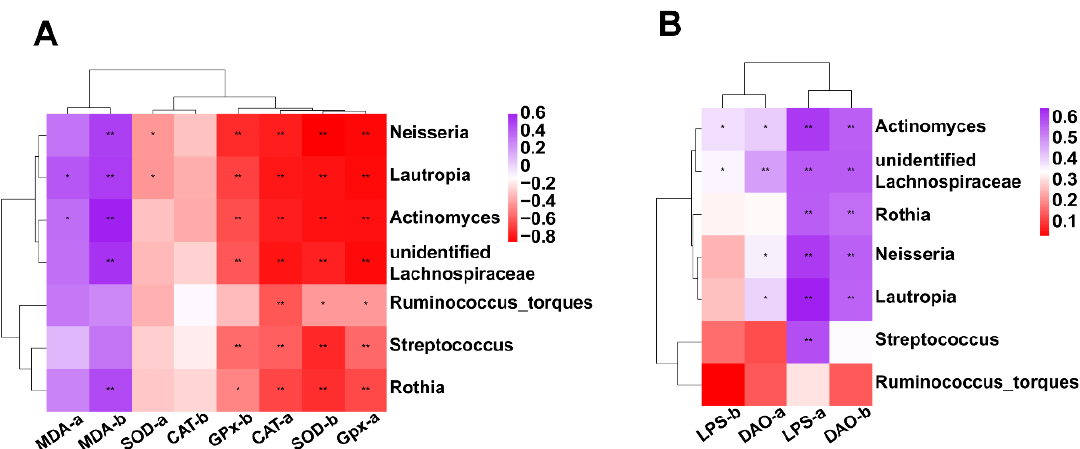
Figure 10. Correlation coefficient and significant analysis between gut microbiota (at genus level) and the parameters of antioxidant capacity or intestinal permeability of the heat-stressed broilers ( A ) Correlation between intestinal microbiota (at genus level) and antioxidant activity. “a” represents the parameters on day 28, and “b” represents the parameters on day 42. ( B ) Correlation between intestinal microbiota (at genus level) and permeability. “a” represents the parameters of 28-day-old broilers, and “b” represents the parameters of 28-day-old broilers. The purple to red color represents an axis from positive correlation to negative correlation. “*” indicates a significant difference between groups where p < 0.05. “**” indicates a significant difference between groups where p <